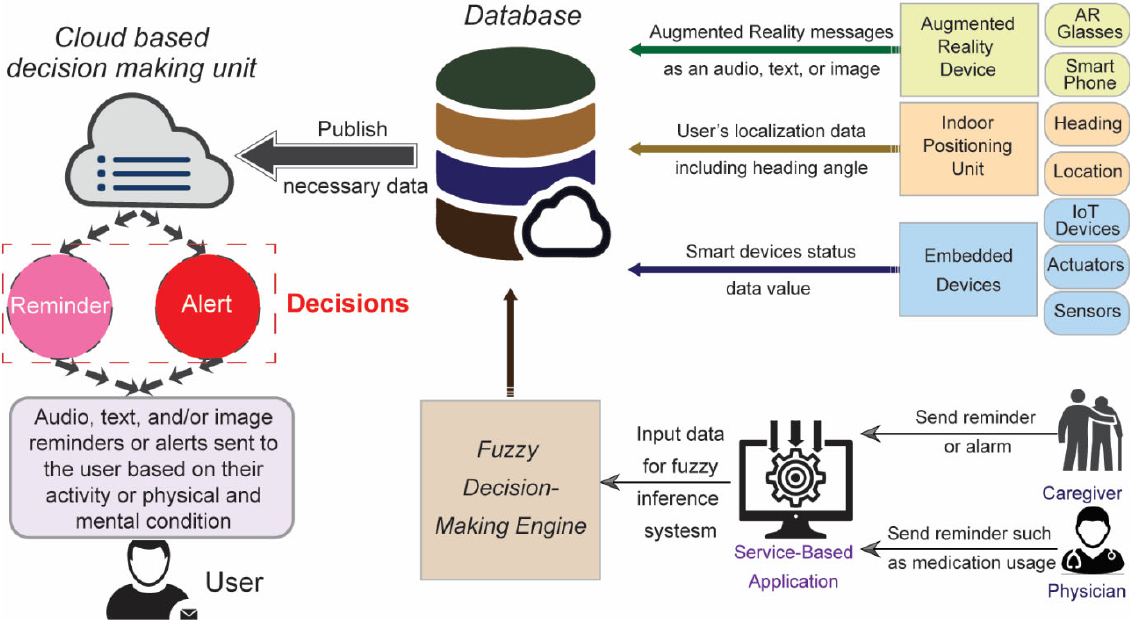
Figure 1. The proposed model for developing an AAL system. The model has four main components: (1) an indoor location and heading measurement unit in the local fog layer, (2) an AR application to make interactions with the end user, (3) a fuzzy decision ‐ making system to handle the direct and environmental interactions with the user, and (4) a service ‐ based application for caregiv ‐ ers or physicians to monitor the situation in real time and send reminders once required.